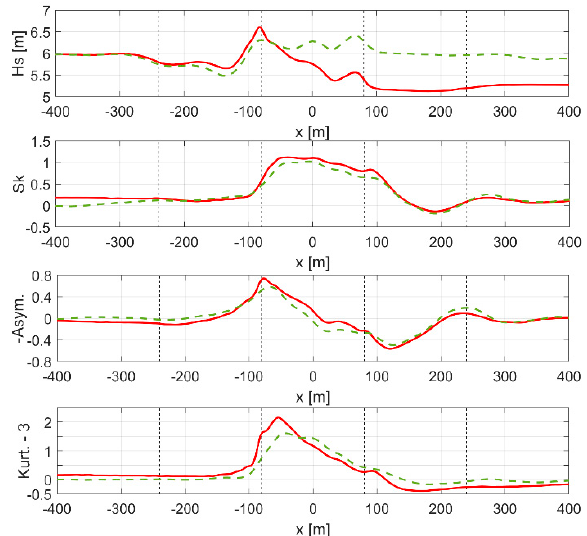
Figure 14. Comparison for wave case H6T12 of the statistical quantities between the 1D long-crested simulation (solid red) and the short-crested simulation (green dashed).